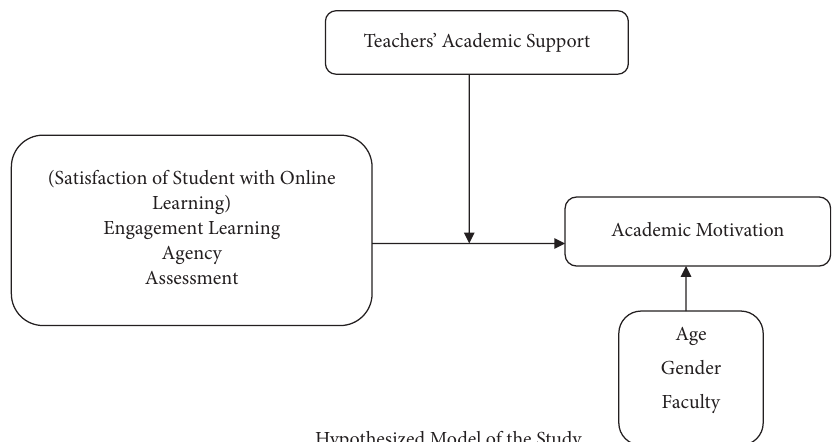
Figure 1: Hypothesized model of the study.